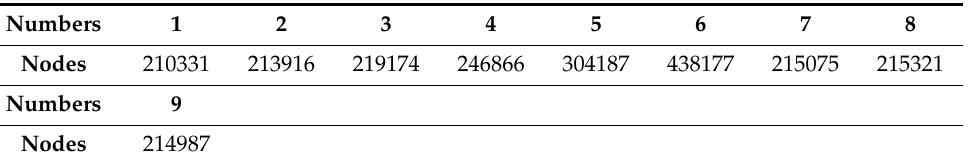
Table A1. Node information for the nine single